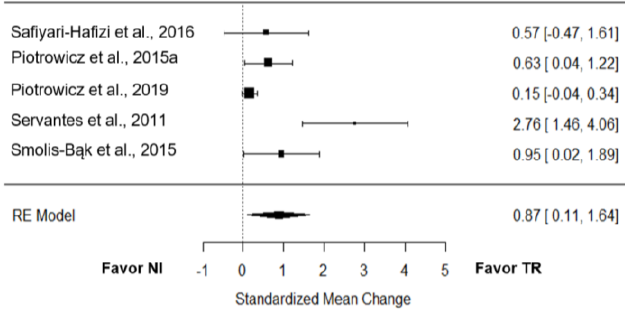
Figure 2. Effect of TR on VO2 peak compared to NI [22,24,26 – 28].